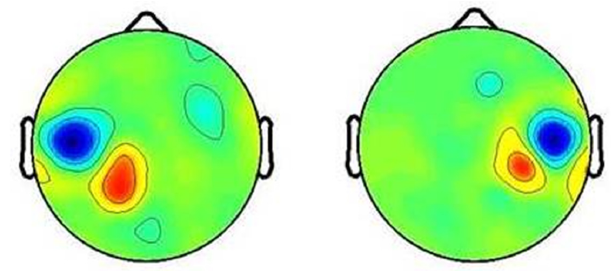
Figure 2. Left and right mu component cluster topographic scalp maps.